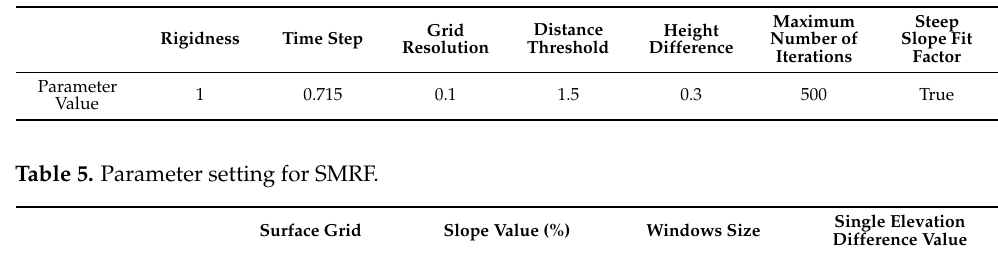
Table 4. Parameter setting for CSF.